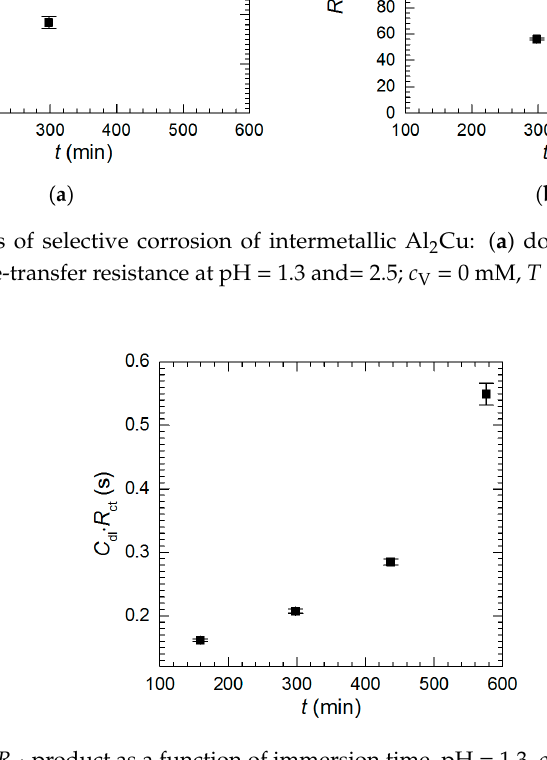
Figure 15. C dl · R ct product as a function of immersion time, pH = 1.3, c V = 0 mM, T = 303 K.